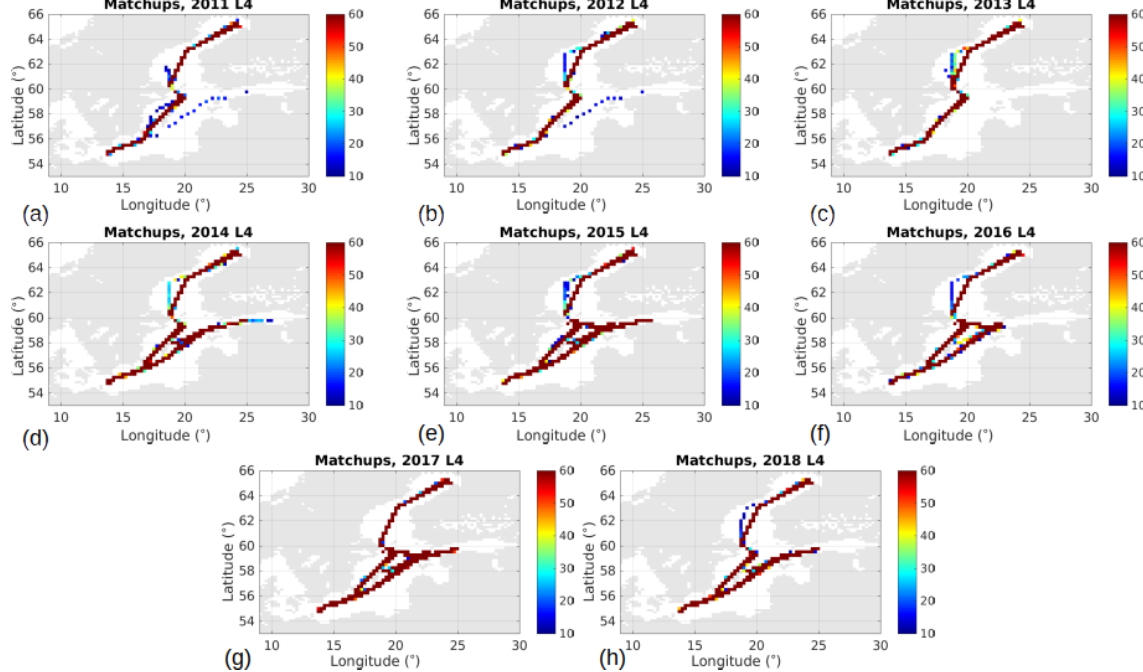
Figure 19. Comparison of L4 SSS and ferry data: number of match-ups for each grid point in the map per year (from a 2011 to h 2018). Table 4. Global statistics of Baltic+ L3, L4 and filtered L4 (not considering extrapolated measurements from reanalysis) SSS products against SeaDataNet in situ